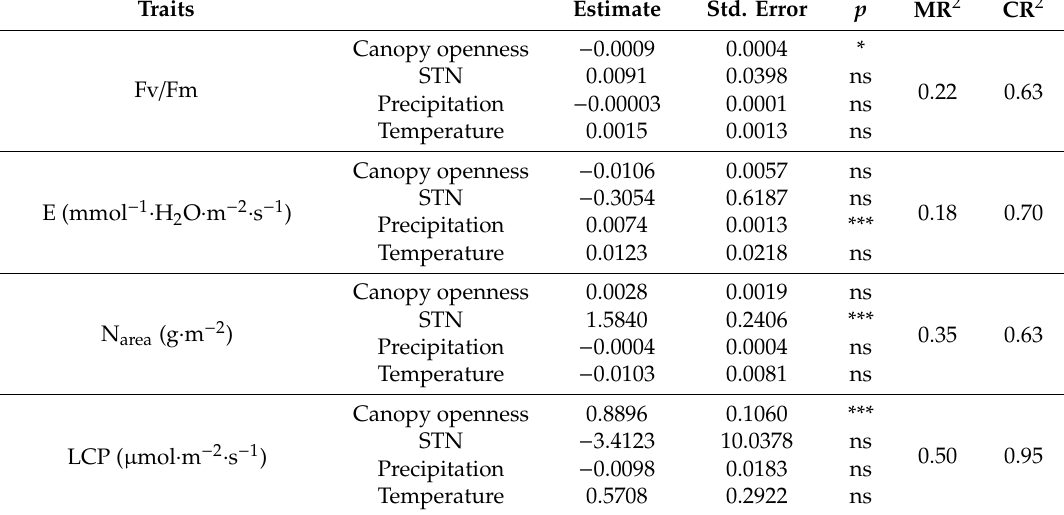
Table 4. Effect of environment factors on each leaf traits (n = 144) of M. condensatus (generalized linear mixed model—GLMM). Response variables are maximum quantum yield of PSII (Fv / Fm); transpiration rate (E); leaf N content (Narea); light compensation point (LCP); leaf mass per area (LMA); light-saturated photosynthetic rate (Amax); water use efficiency (WUE); photosynthetic N use efficiency (PNUE), respectively. MR 2 Significance of the coefficients: ns p > 0.05, * p < 0.05, ** p < 0.01, *** p <